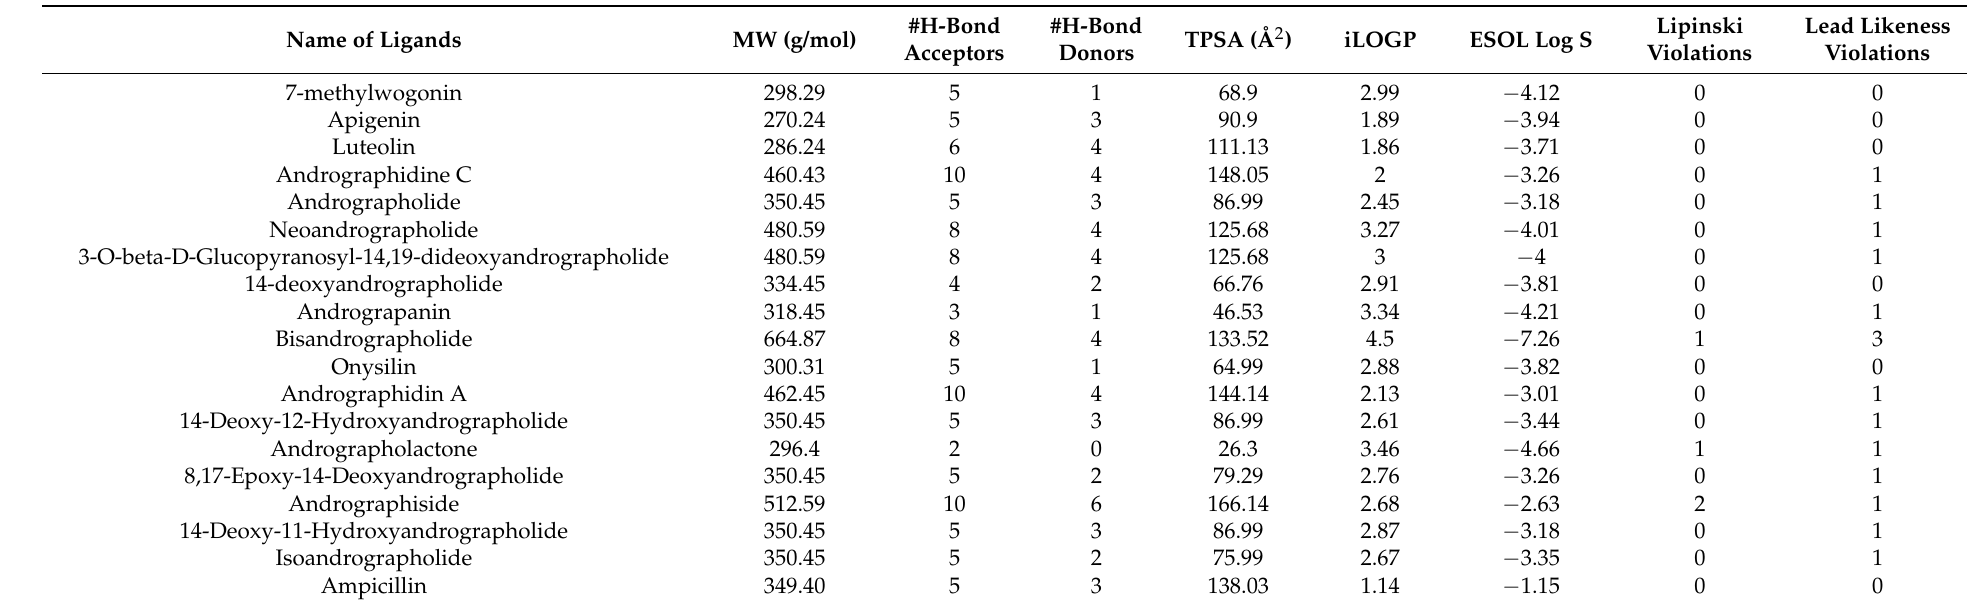
Table 3. Drug-like properties of